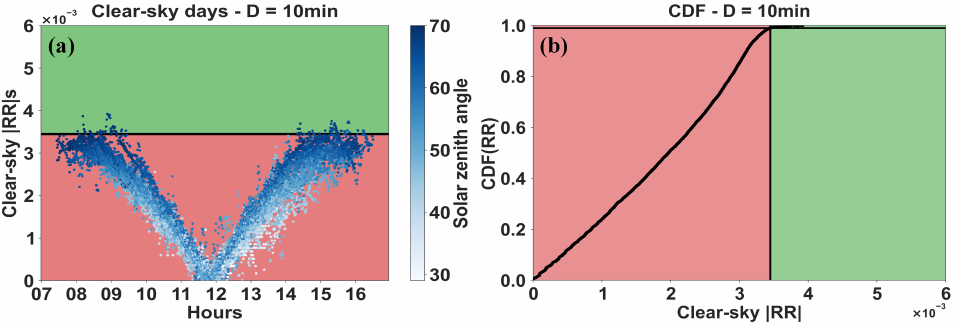
Figure 2. ( a ) Scatter plot and ( b ) CDF function of ramp rates (RRs) for clear-sky conditions at time horizon D = 10min. The solid black lines indicate the threshold limit (99th quantile) that classifies the no-ramp (red area) and ramp (green area) events. The blueish color bar refers to the solar zenith